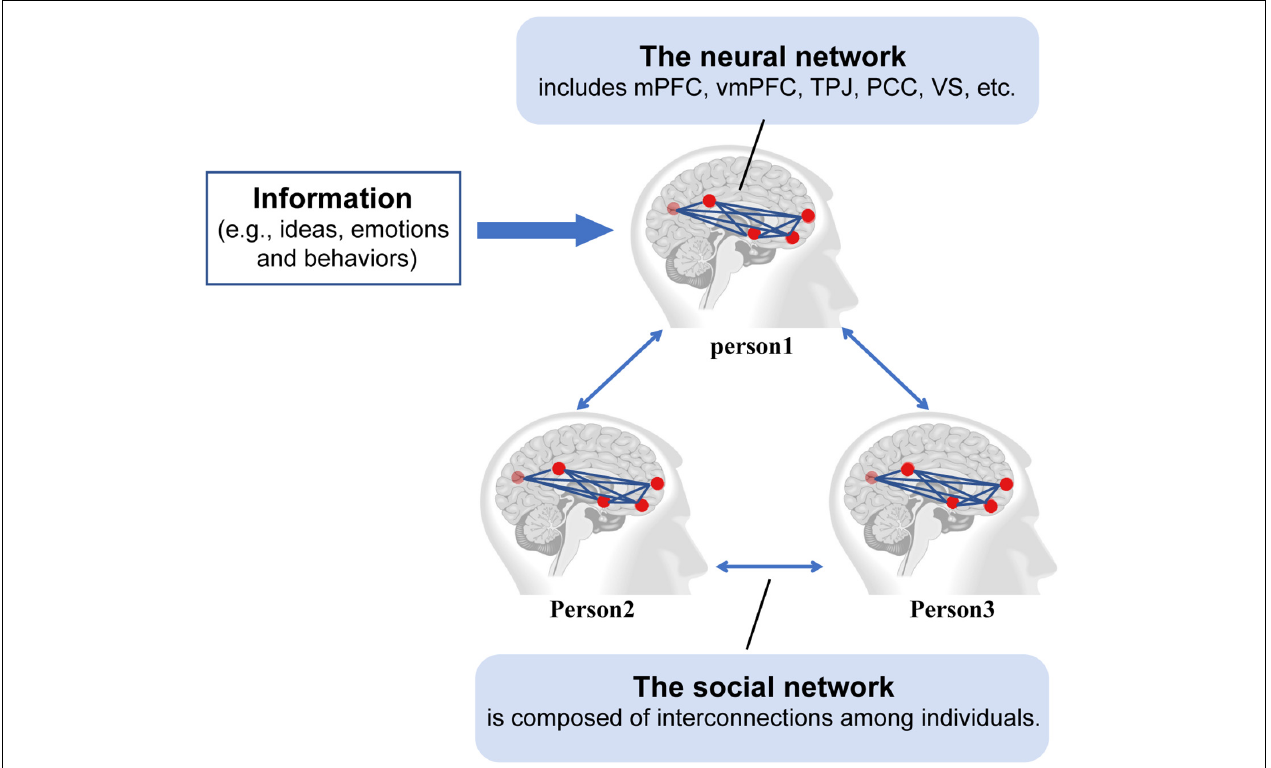
FIGURE 2 | Multilayer brain-social networks. Information (e.g., ideas, emotions, and behaviors) processed in one brain region in person 1 can be transmitted to another region in person 1 via the neural network. The transmission of information can lead to a change of opinion in person 1, which can then be transmitted from person 1 to person 2 and person 3 via the social network. mPFC refers to the medial prefrontal cortex, vmPFC refers to the ventromedial prefrontal cortex, TPJ refers to the temporo-parietal junction, PCC refers to the posterior cingulate cortex, and VS refers to the ventral